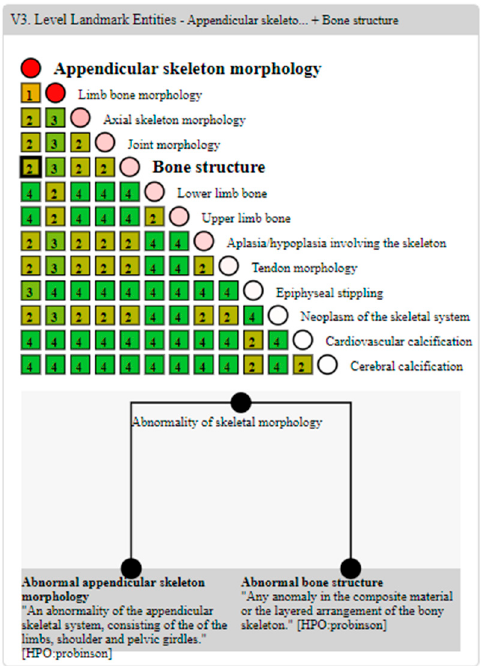
Figure 28. An overview of the Level Landmark Entity Subview, representing the 3rd level of the “Abnormality of Skeletal System” ontology section.